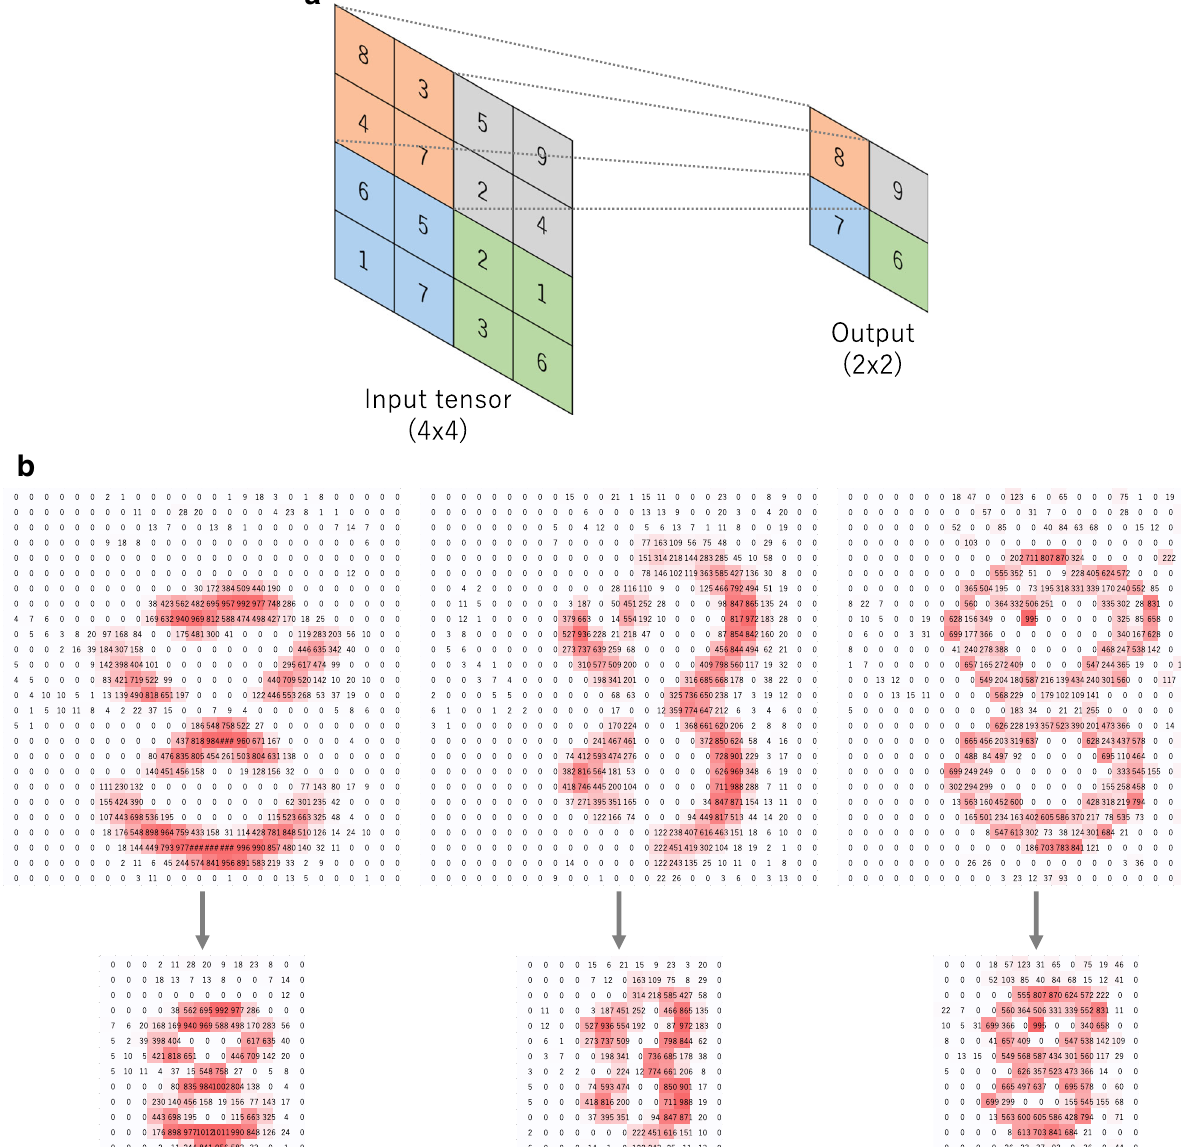
Fig. 6 a An example of max pooling operation with a filter size of 2 × 2, no padding, and a stride of 2, which extracts 2 × 2 patches from the input tensors, outputs the maximum value in each patch, and discards all the other values, resulting in downsampling the in-plane dimension of an